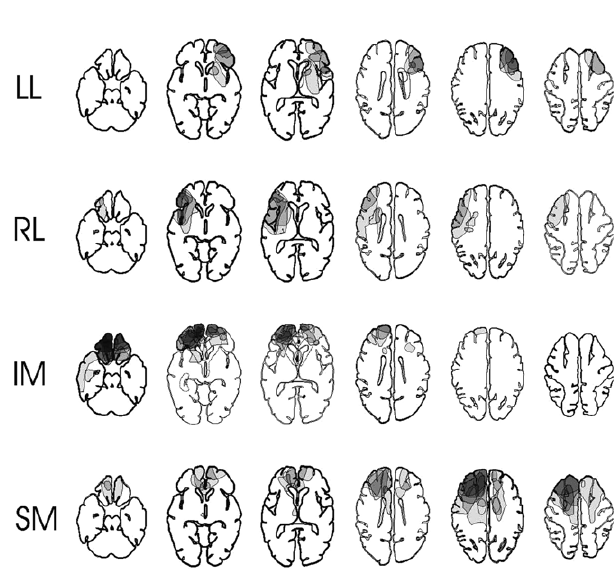
Figure 1. Lesion locations. The fi gure shows the lesion overlaps in the four patient groups (LL = Left Lateral (11 patients); RL = Right Lateral (6 patients); SM = Superior Medial (10 patients); IM = Inferior Medial (14 patients)). Darker shading indicates a greater number of patients with lesions affecting the region. The scans for one patient in each of two groups (LL and IM) were unavailable for